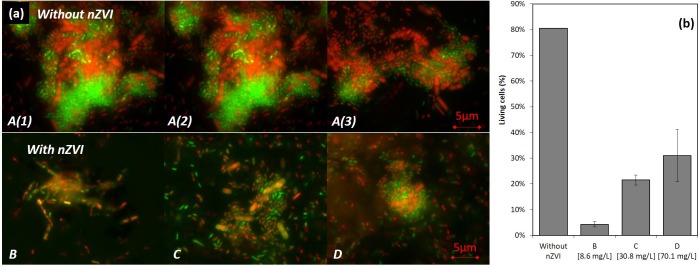
LIVE/DEAD® observations (illustration images) (a) and results of counting (b) of bacteria after 43 h of incubation (24 h after nZVI addition). A [A(1), A(2), and A(3)] images are for control samples where huge living cells aggregates were observed, and B/C/D are images of cultures containing nZVI. Please note that images from (a) were not those used for LIVE/DEAD counting results presented in (b).